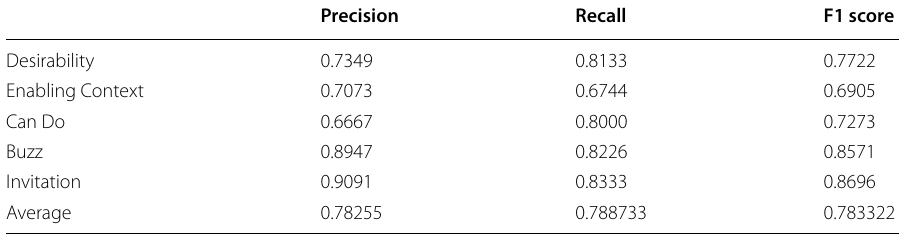
Table 9 Results for BERTweet embedding extraction scenario EE#3 Precision